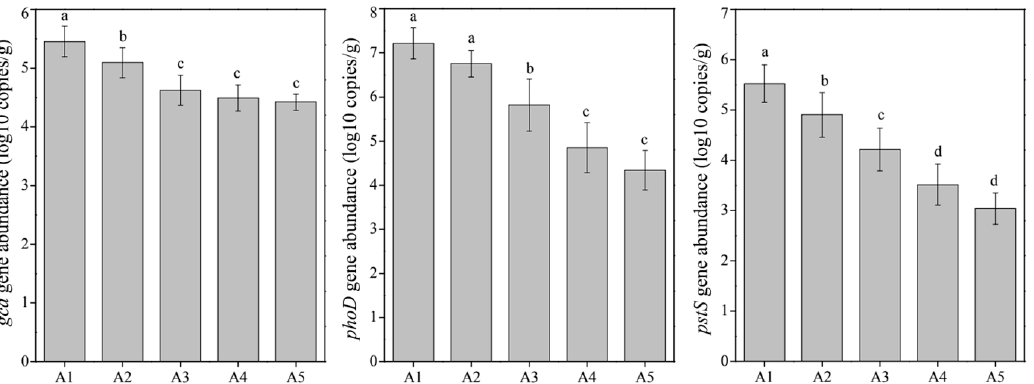
Figure 4. Differences in enzyme activities of dehydrogenase and catalase among five TiO 2 NP addi- tion amounts (i.e., A1, A2, A3, A4, and A5). Lowercase letters above the columns represent signifi- cance ( p < 0.05).